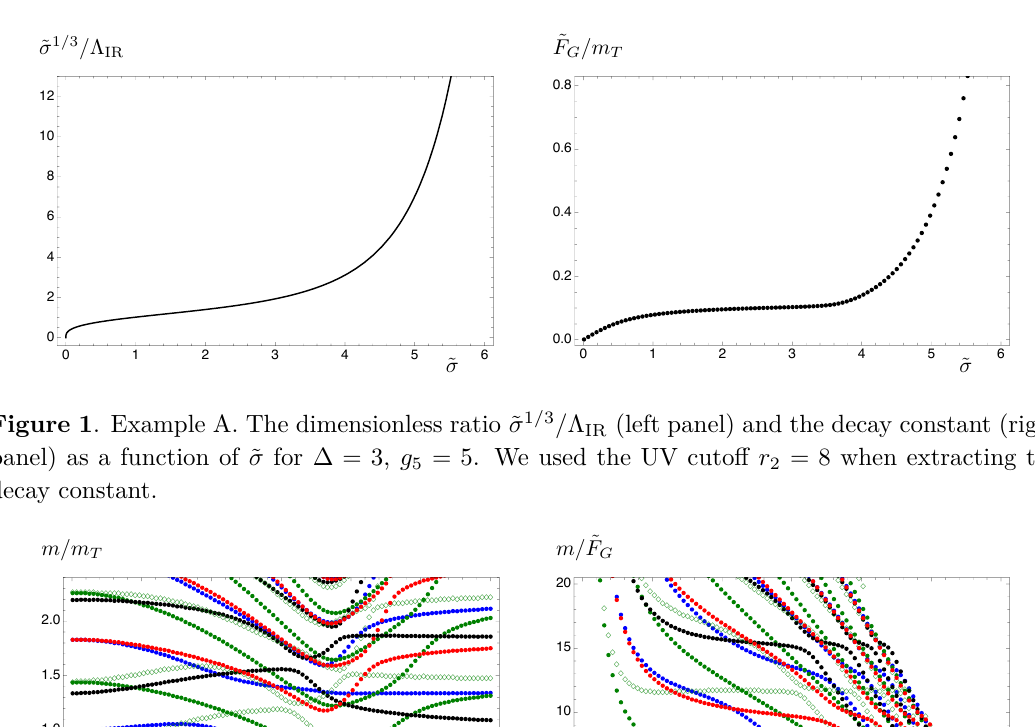
Figure 2 . Example A. Spectrum as a function of ˜ σ for ∆ = 3 , g 5 = 5 , r 1 = 0 , r 2 = 8 . The left panel is normalized to the mass m of the lightest tensor, while the right panel is normalized to the T decay constant ˜ F = F . The colour coding for the spectrum is: scalar (blue), tensor (red), G G /N C pseudoscalar (black), vector (green), axial-vector (green diamonds). Since ∆ > 2 , there is also a massless dilaton in the spectrum, as can be seen from figure 3; due to the numerical resolution deployed only the Goldstone is shown in the present two plots. In the right panel, it is understood that heavier states are present in the right-upper